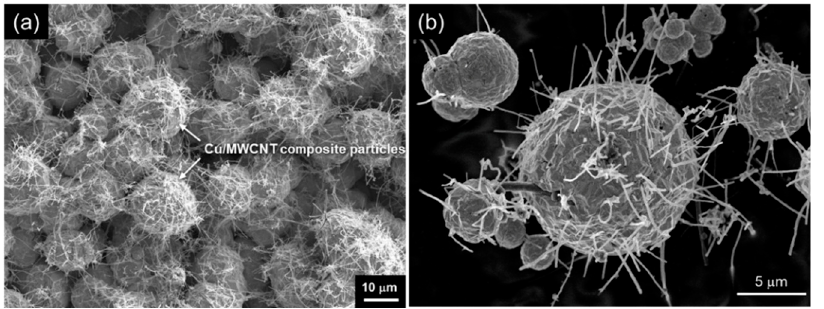
Figure 8. SEM images of ( a ) Cu/MWCNT composite immediately after electrodeposition and ( b ) Cu/MWCNT composite powder separated by ultrasonification. (Figure 8 is adapted from reference [35]).